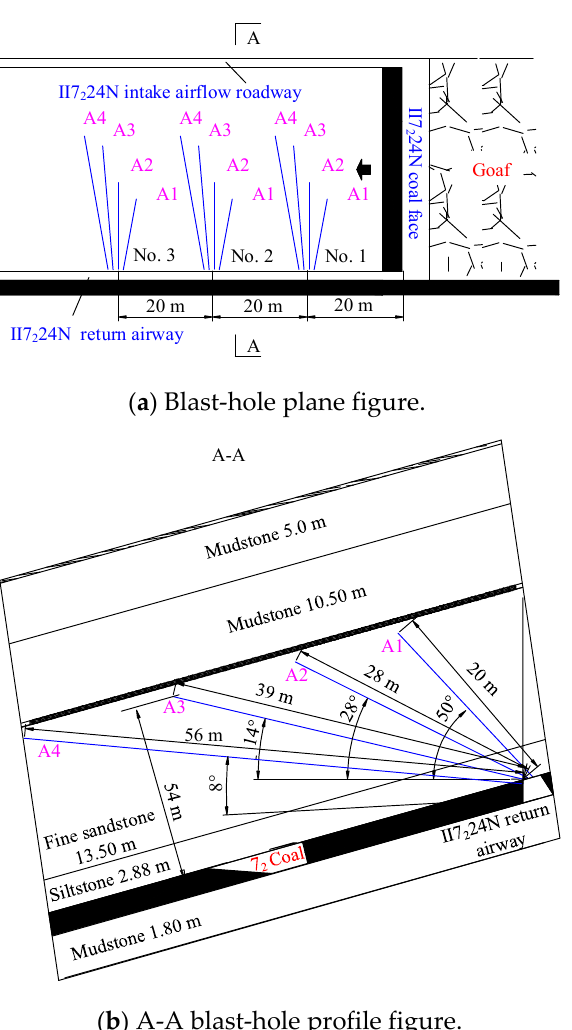
Figure 11. Deep-hole blasting drilling layout: ( a ) blast-hole plane figure and ( b ) A - A blast-hole profile figure. Table 5. Parameters of blast-hole and charge weight.